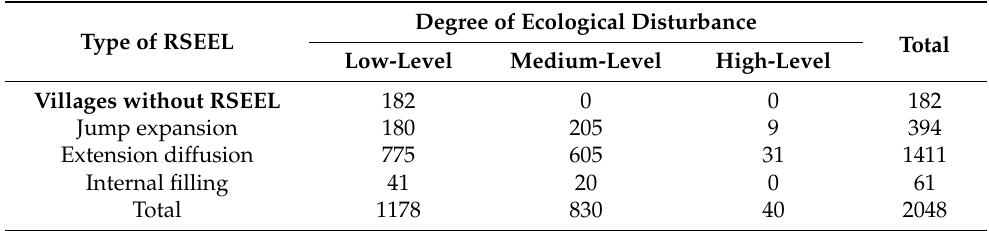
Table 1. Cross-analysis of encroachment type and degree of ecological disturbance in RSEEL in Nantong. Type of RSEEL